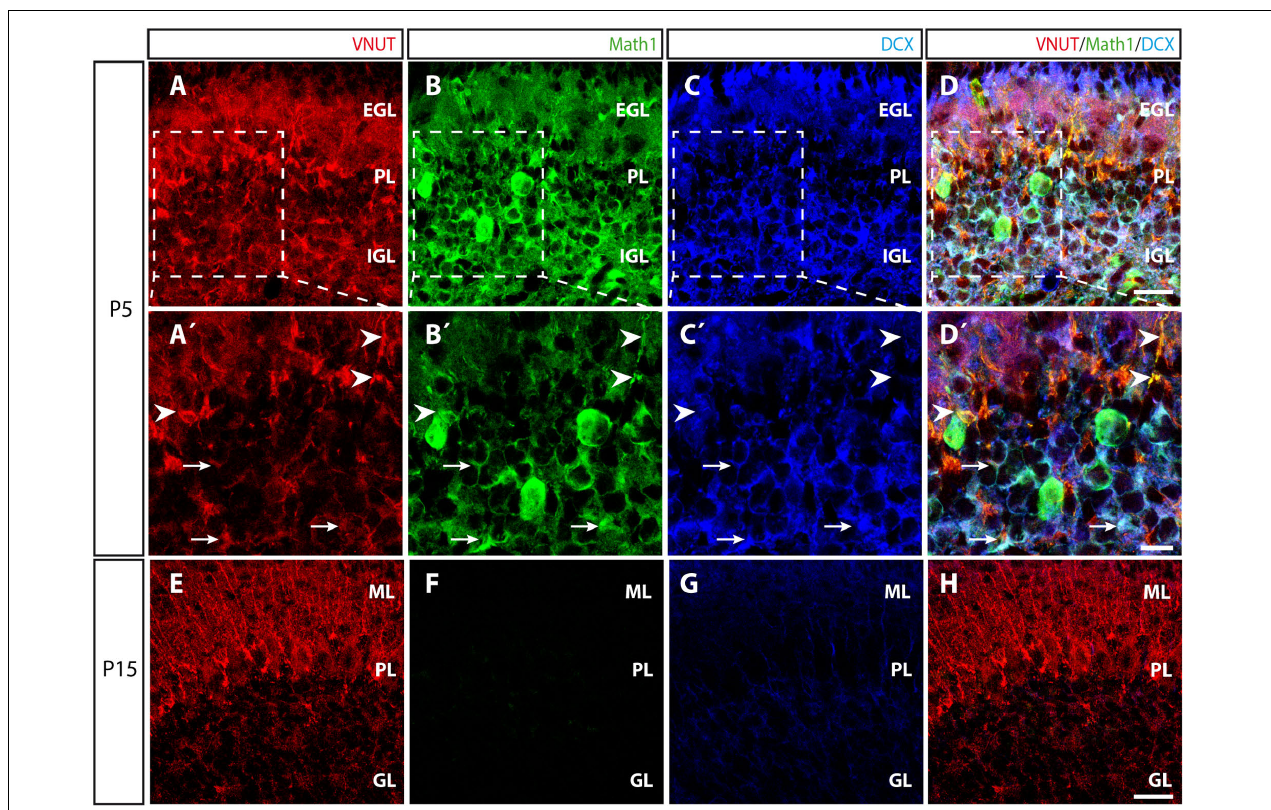
FIGURE 7 | Distribution of VNUT during the postnatal development of the cerebellar cortex. (A–D) Representative confocal images of P5 cerebellar sections showing triple immunofluorescence for VNUT (red), Math1 (a marker of committed GCPs) (green) and DCX (a marker of immature neurons) (blue), and the overlaid image. Scale bar: 20 µ m. (A (cid:48) –D (cid:48) ) Higher magnification of the selected region at P5 in which the arrowheads indicate the co-localization of the immunoreactivity for VNUT and Math1. The arrows indicate the co-localization of VNUT, Math1 and DCX immunostaining. Scale bar: 10 µ m. (E–H) Representative micrographs of P15 cerebellar sections showing triple immunofluorescence for VNUT (red), Math1 (green) and DCX, (blue) and the overlaid images. Scale bar: 20 µ m. EGL, External Granular Layer; PL, Purkinje Layer; IGL, Internal Granular Layer; ML, Molecular Layer; GL, Granular